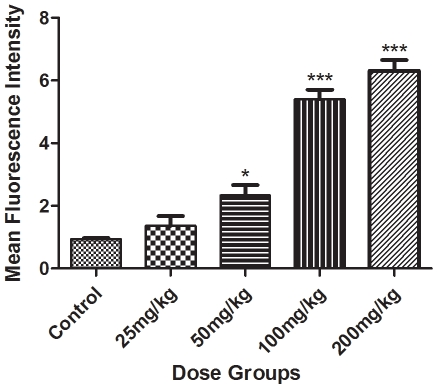
Mean fluorescence intensity of dichlorofluorescein (DCF).Intracellular ROS in peripheral blood mononuclear cells (PBMC) were analyzed in Apigenin treated animals at different doses (Control, 25, 50, 100 and 200 mg/kg) using fluorescent probe 2′, 7′-dichlorofluorescein-diacetate. The asterisks indicate significance of differences (*-p<0.05; ** -p<0.01; ***-p<0.001) in comparison to control.